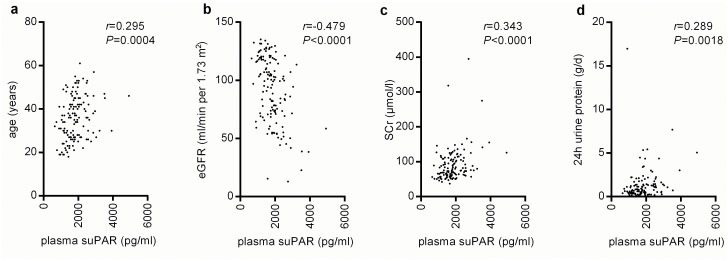
The correlations between the plasma soluble urokinase receptor (suPAR) with age (a), eGFR (b), SCr (c) and 24-h urine protein (d) in univariate analysis.eGFR, estimated glomerular filtration rate; SCr, serum creatinine.